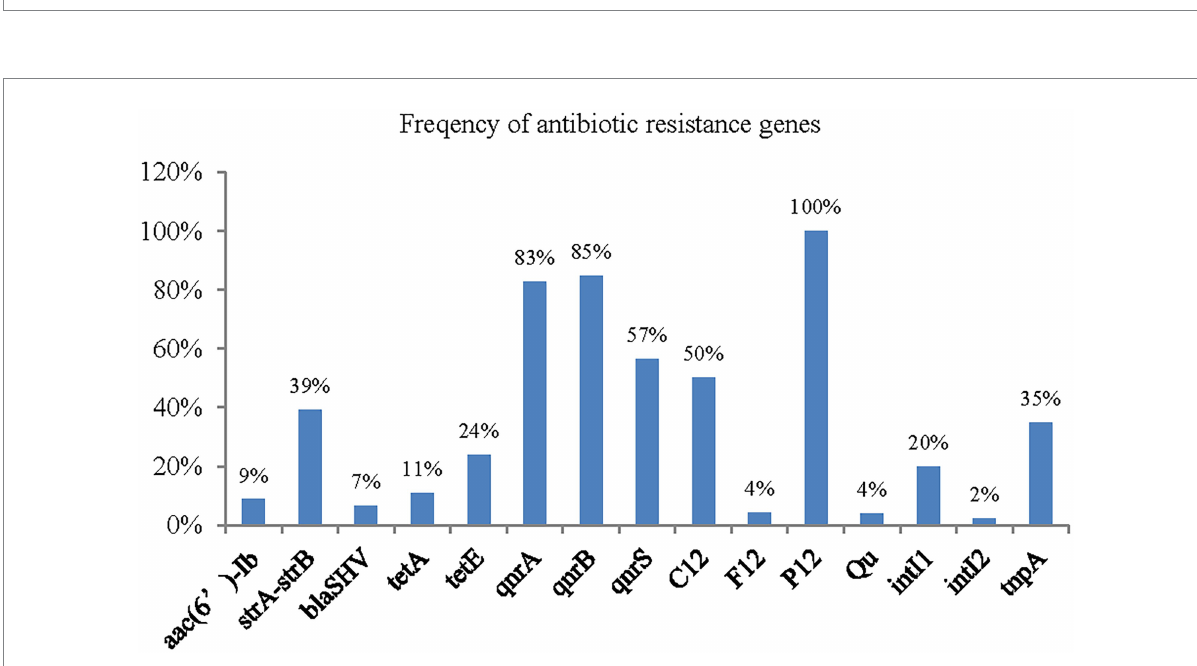
FIGURE 5 The frequency of antimicrobial resistance genes of A.